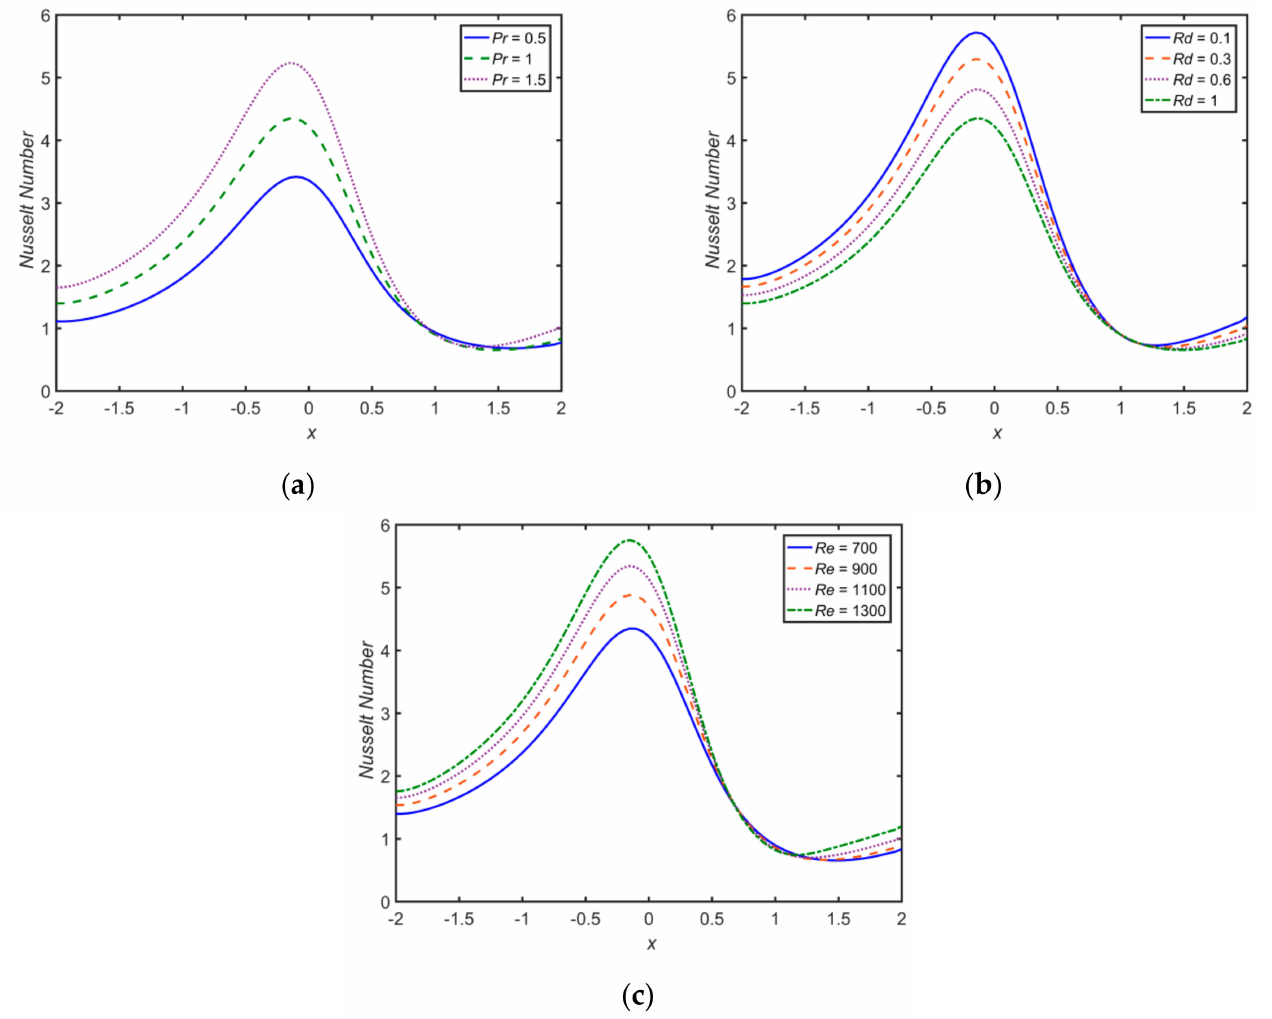
Figure 18. Nusselt profiles for ( a ) Pr = 0.5, 1, and 1.5; ( b ) Rd = 0.1, 0.3, 0.6, and 1; and ( c ) Re = 700, 900, 1100, and 1300; with M = 5 and St = 0.02, at t =